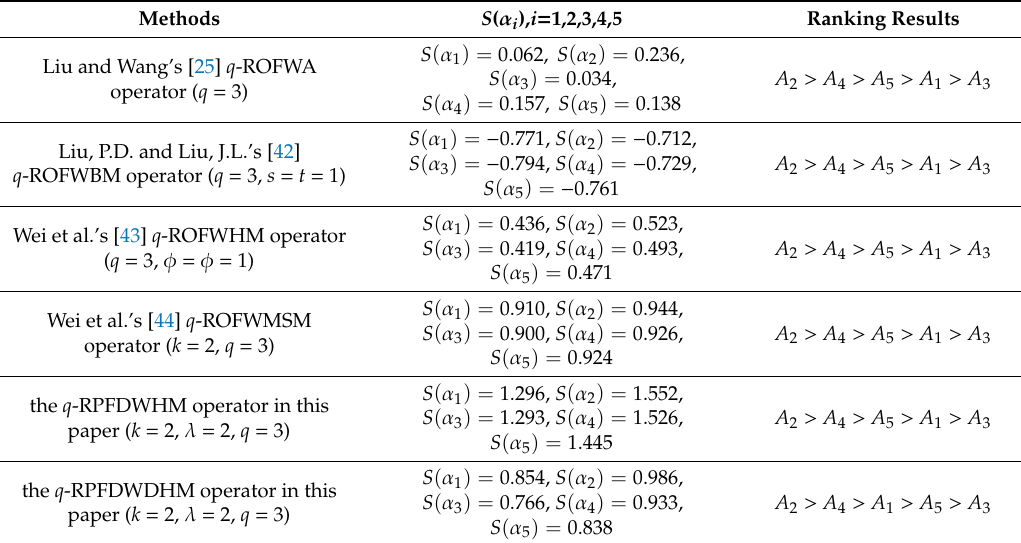
Table12. Scorevaluesandrankingresultsusingouroperatorandsome q -rungorthopairfuzzyoperators. Methods S ( α i ), i = 1,2,3,4,5 Ranking